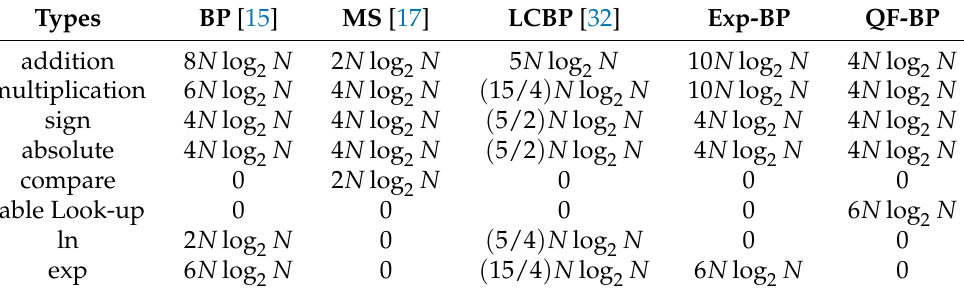
Table 5. The number of operation types included in different algorithms in each